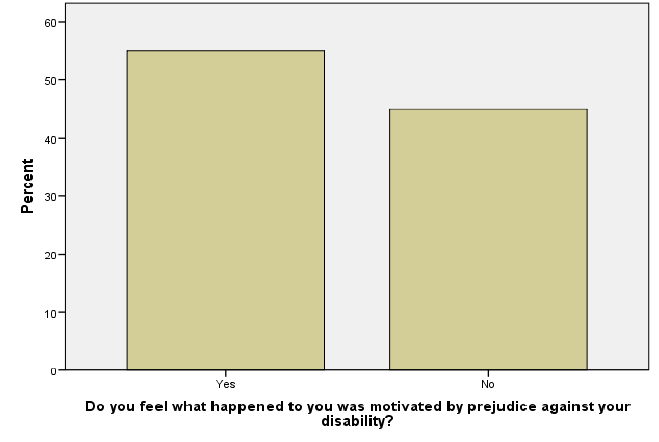
Figure 2: Crime/Abuse Committed to Disabled Children Because of